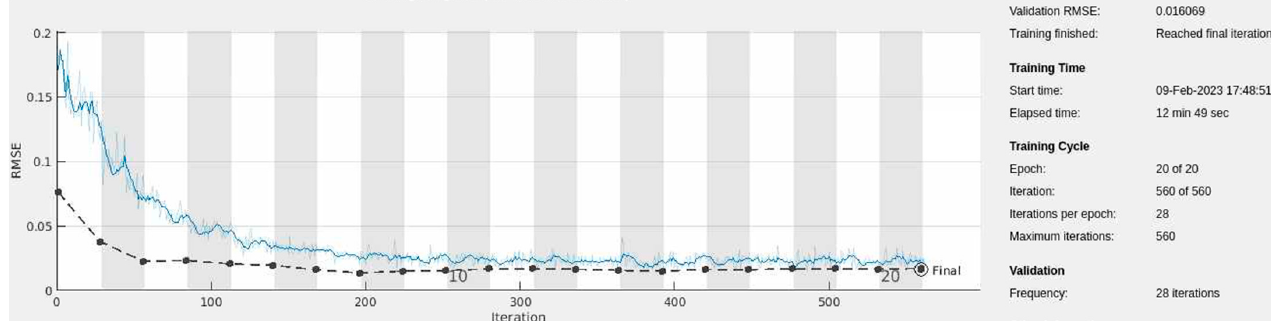
Figure 8. Training progress for the proposed hybrid BA-CNN-LSTM algorithm (artificial porosity images).